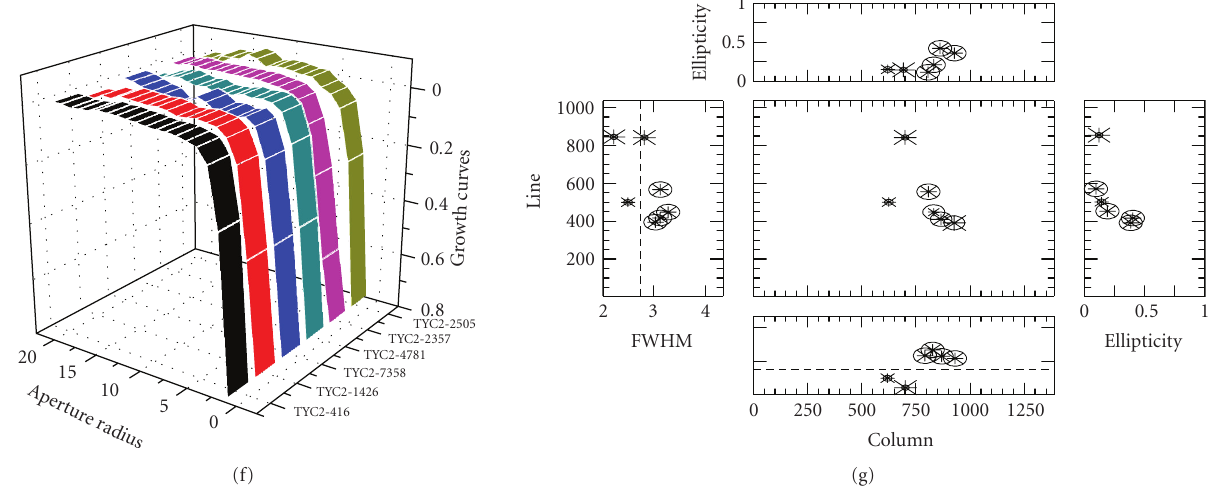
Figure 3: Example of growth curves acquired with a continuous exposure time of 0.13 seconds per frame, under moderate sky condition (see values in the text). The position of the stars may be found in the sky field of Figure 1 reading the the Tycho-2 identification number (id number) labeled in y -axis. For each star are reported the values of the ellipticity, the FWHM using as best fit a Mo ff at profile, and the pixel